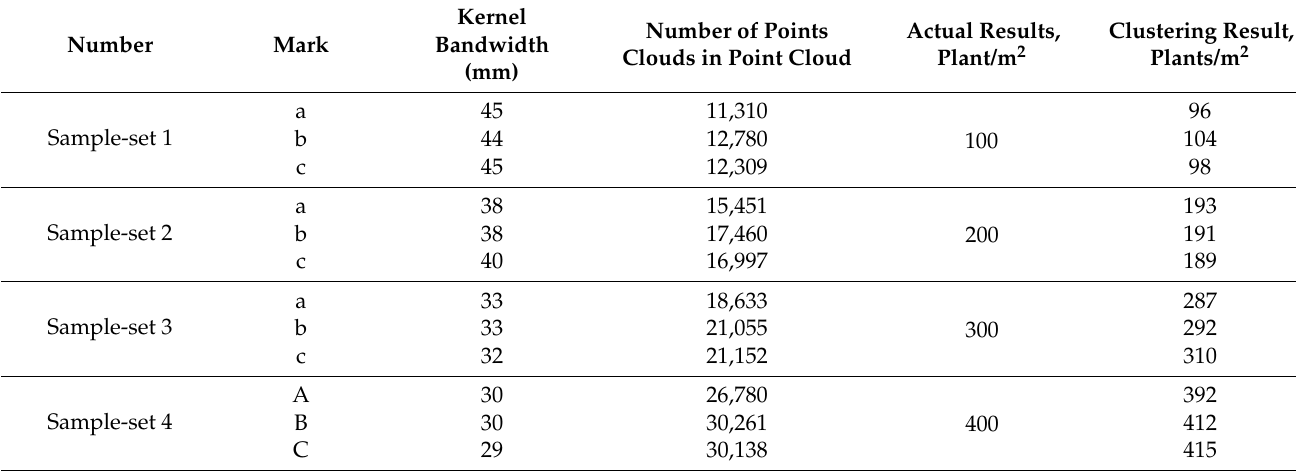
Figure 8. Mean-shift clustering result in standard experiment group. Table 4. Mean-shift clustering parameters and results of the standard experiment